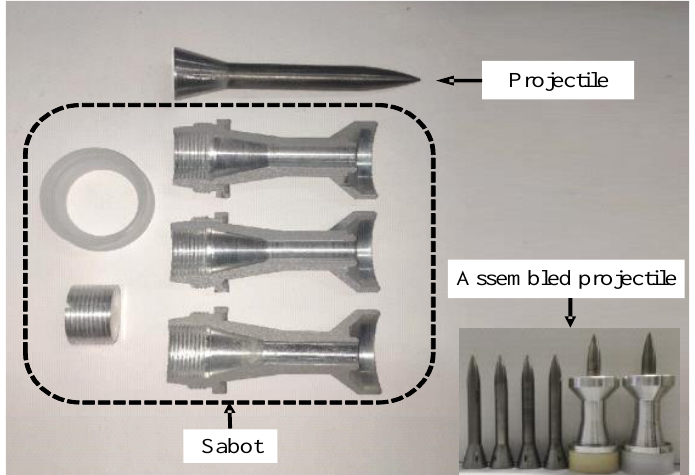
Figure 2. Projectiles used for impact experiment.